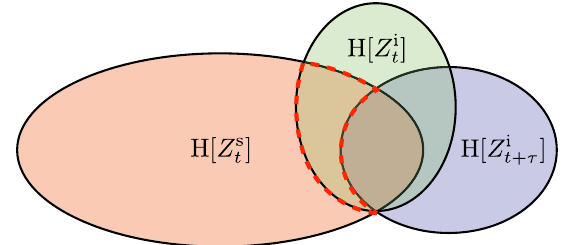
FIG. 2. Information diagram for a local computation: Informa- tion atoms of the noninteracting subsystem H ½ Z s (red ellipse), t (cid:2) the interacting subsystem before the computation H ½ Z i (green t (cid:2) ellipse), and the interacting subsystem after the computation H ½ Z i (blue ellipse). The initial state of the interacting sub- t þ τ (cid:2) system shields the final state from the noninteracting subsystem; graphically the blue and red ellipses only overlap within the green ellipse. The modularity dissipation is proportional to the differ- ; Z s ; Z s ence between information atoms I ½ Z i and I ½ Z i . t t (cid:2) t (cid:2) t þ τ Because of statistical shielding, it simplifies to the information ; Z s Z i atom I ½ Z i , highlighted by a red dashed t t j t þ τ (cid:2)